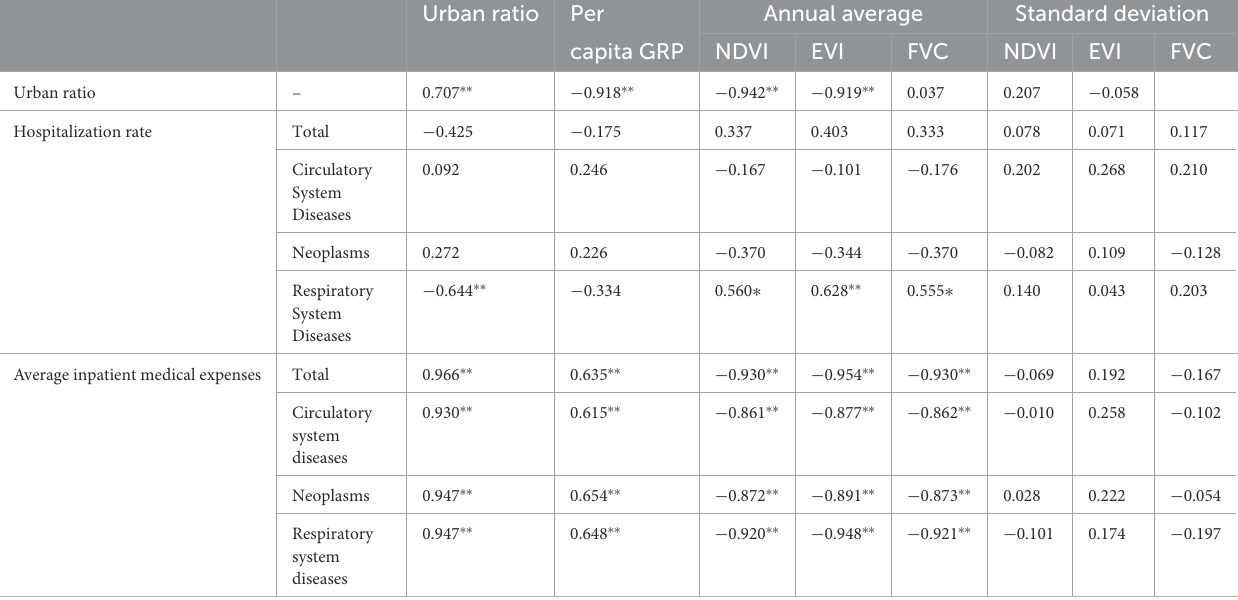
TABLE 2 Correlation analysis of greenspace indicators, urban ratio, and per capita GRP with hospitalization rate and average inpatient medical expenses. Urban ratio Per Annual average Standard deviation capita GRP NDVI EVI FVC NDVI EVI